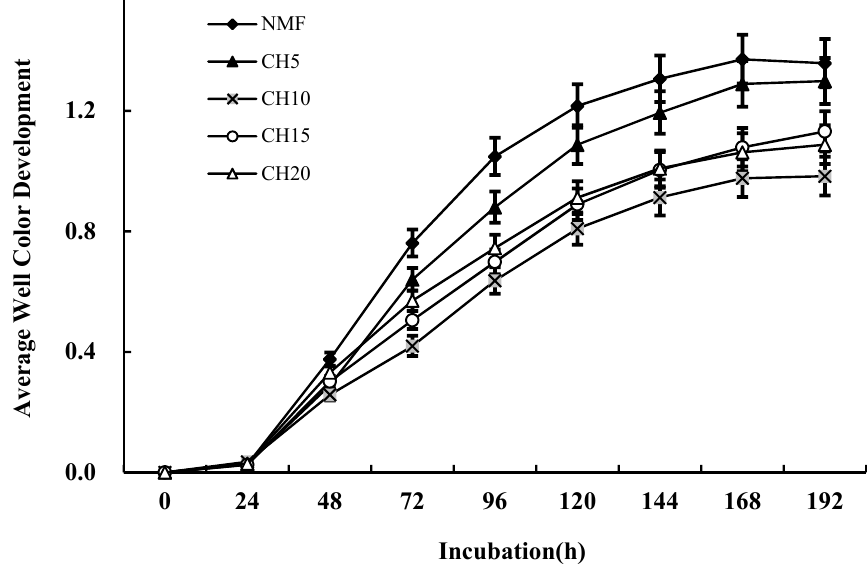
Figure 2. Average well color development (AWCD) of soil microorganisms from natural broad-leaved forest (NMF) stands and Chinese hickory stands managed intensively for 5 (CH5), 10 (CH10), 15 (CH15), and 20 (CH20) years.